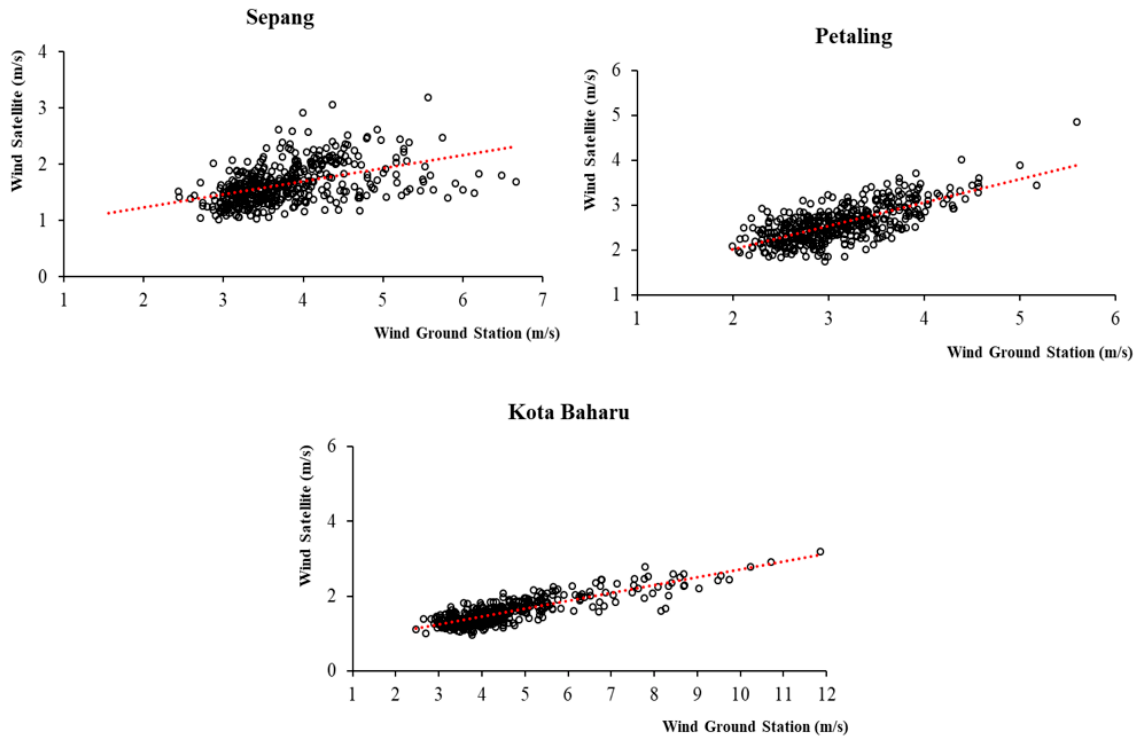
Figure 5 . Correlation between wind speed data from EO and ground-based stations ( n = 3), 2011 to 2019, Malaysia